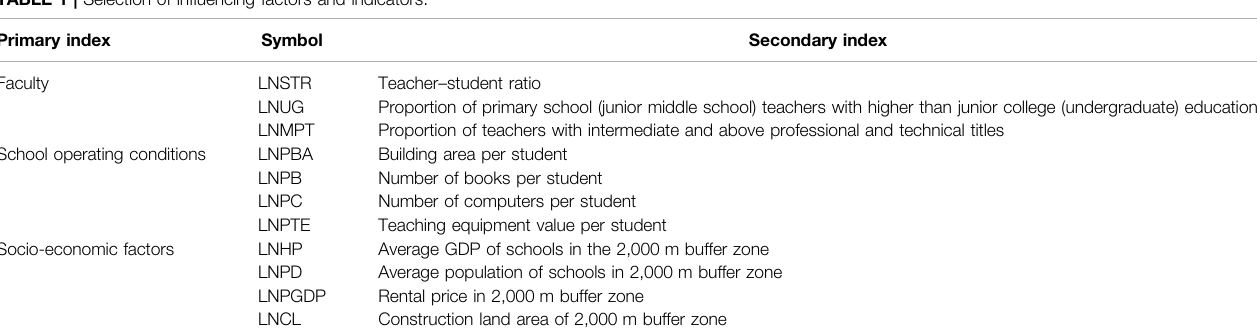
TABLE 1 | Selection of in fl uencing factors and